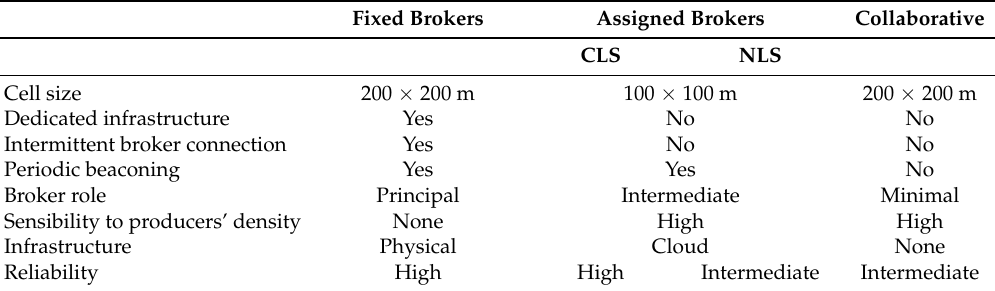
Table 6. Differences between